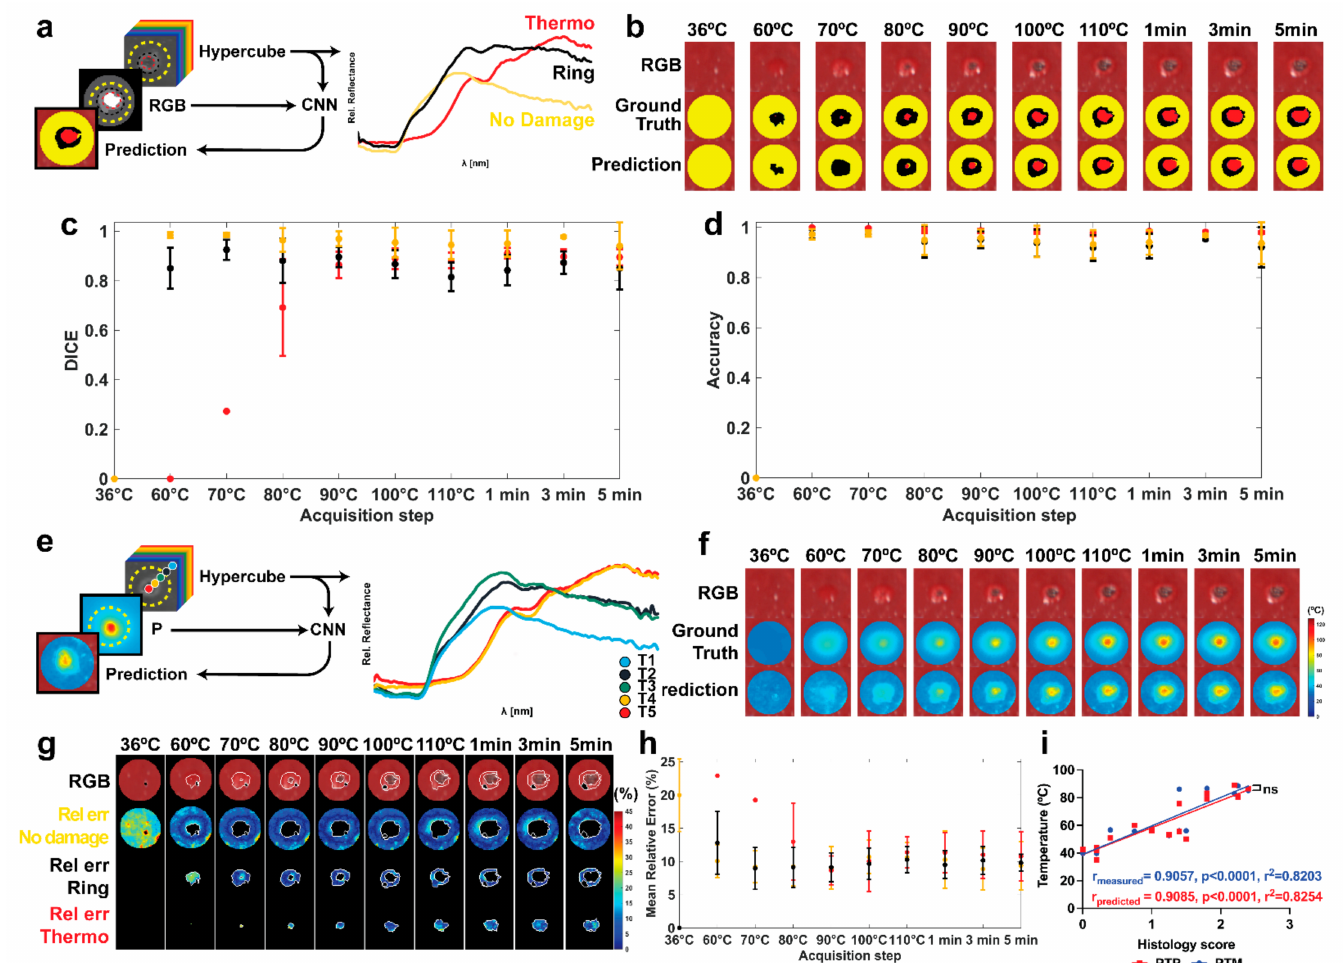
Figure 6. ( a ) Dataset and output of the TDSM, and relative reflectance for each class. ( b ) The normal RGBs are shown with ground truth and predicted pixel classes within the ROI of the first test. ( c ) Mean DICE scores for the three classes with standard deviation for all the acquisition steps. ( d ) Mean accuracy was also measured with standard deviation. ( e ) Dataset and output of the PTPM, and relative reflectance for several pixels associated with specific temperature value (T 1 . . . T 5 ) provided by the IR camera. ( f ) The normal RGBs are shown with ground truth and predicted peak temperature maps within the ROI of the first test. Predicted and ground truth temperature values, in the range 0–125 ◦ C, are overlayed to the correspondent RGB images. ( g ) Maps of the Rel err (%) for the three classes. Damage class borders are highlighted in white on the RGB images. The black spot shows the pixels selected as specularity in the images. ( h ) MRE % and its standard deviation in the three areas. ( i ) Linear regression between histology scores and (1) measured peak temperature values (PTM-blue curve), and (2) predicted peak temperature values (PTP-red curve) for the three classes. The parameters resulting from the correlation are also